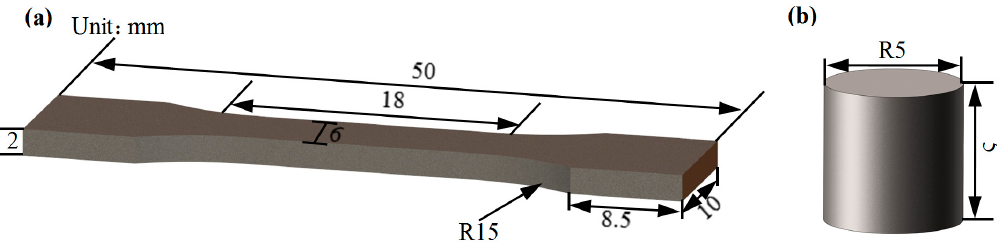
Figure 2. Schematic showing the dimensions of the ( a ) quasi-static tensile specimen and ( b ) dynamic compression specimen.